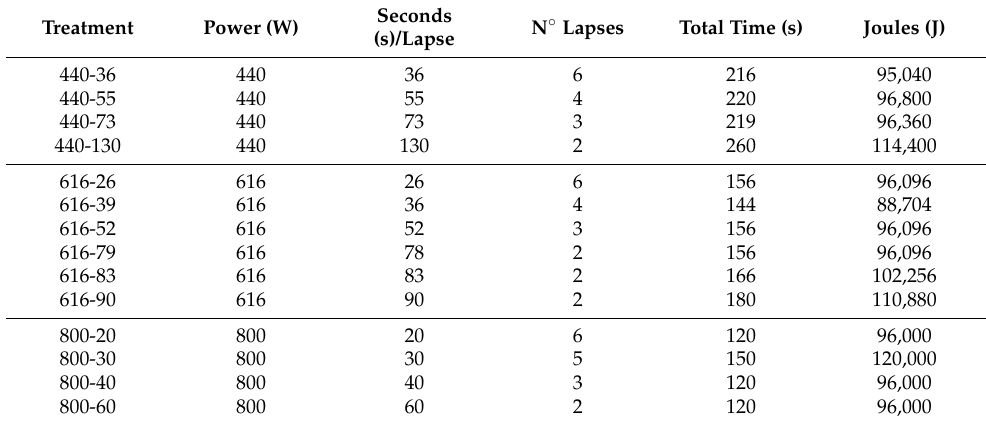
Table 1. Dehydration treatments applied to fresh stigmas of Crocus sativus